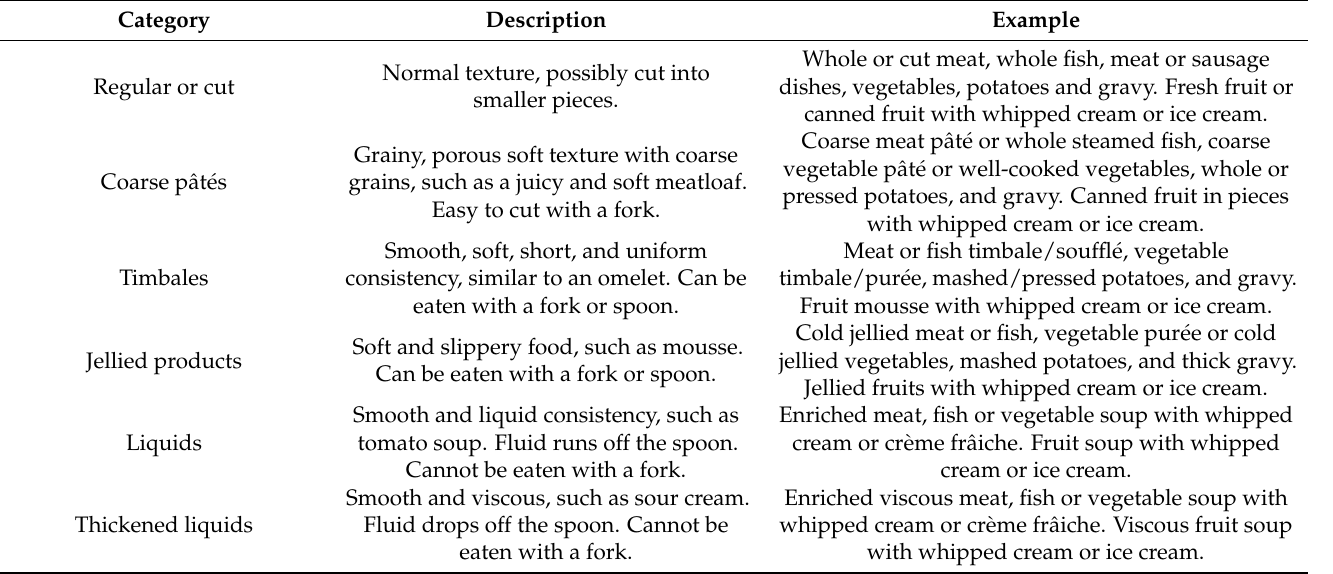
Table 1. Descriptions of the consistencies in the texture guide